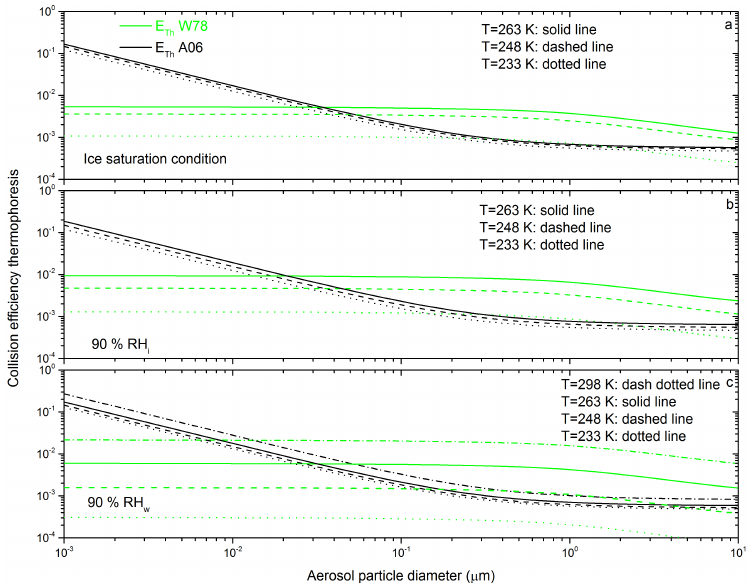
Figure 6. Dependence of thermophoresis on aerosol particle diameter following Andronache et al. (2006) (A06) and Wang et al. (1978) (W78) for a droplet of 80µm diameter: (a) at ice saturation for temperatures of 263, 248 and 233K; (b) at 90% relative humidity with respect to ice; (c) at 90% relative humidity with respect to